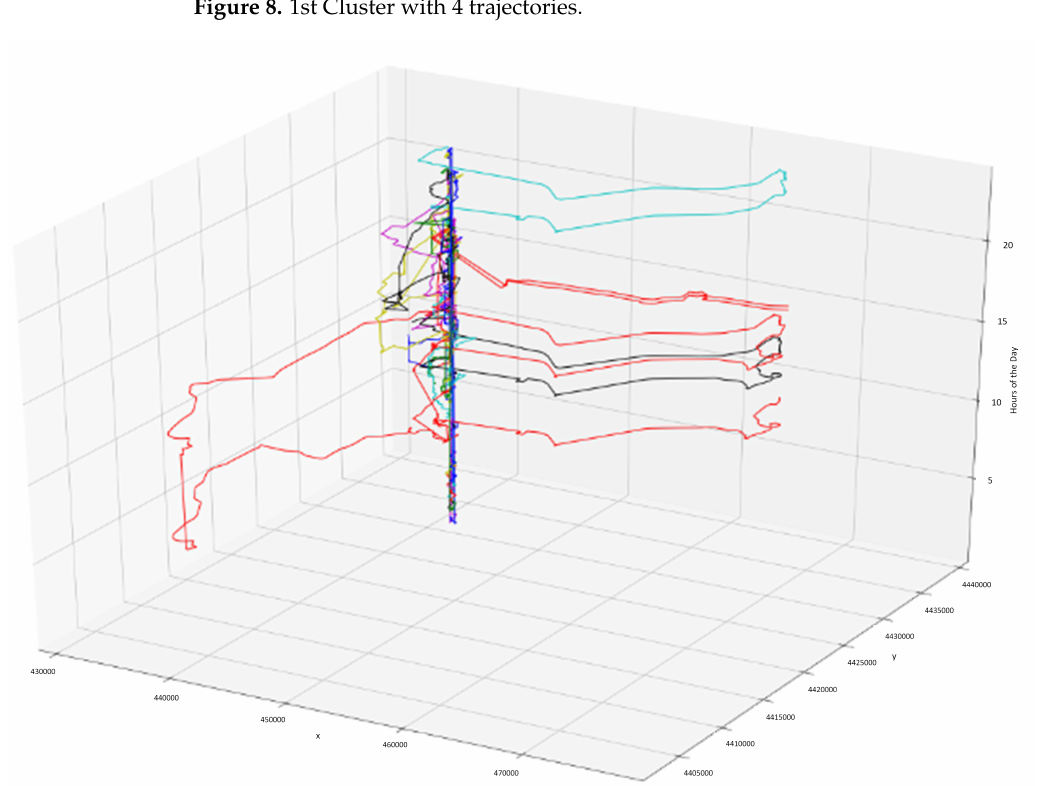
Figure 9. 2nd Cluster with 44